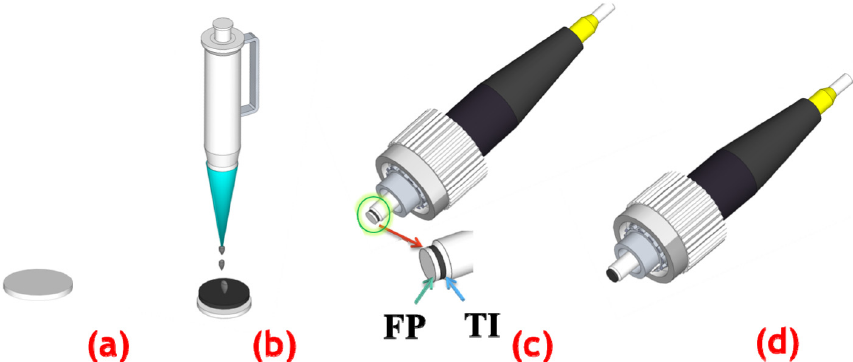
Figure 8. Procedures of the preparation of pure Bi 2 Se 3 -SA film. ( a ) Filter paper (FP) (GVWP02500 Millipore) with a pore size of 0.22 μ m was immersed in deionized water until it soaked completely. ( b ) The Bi 2 Se 3 water solution was dropwise added to the filter paper slowly. ( c ) Shear a small piece from the prepared Bi 2 Se 3 filter paper and put it on the face of a fiber end-facet. ( d ) Put the fiber end-facet with the Bi 2 Se 3 filter paper into acetone solution to remove the filter paper. Reproduced from ref. [81]. Optical Society of America, 2014.